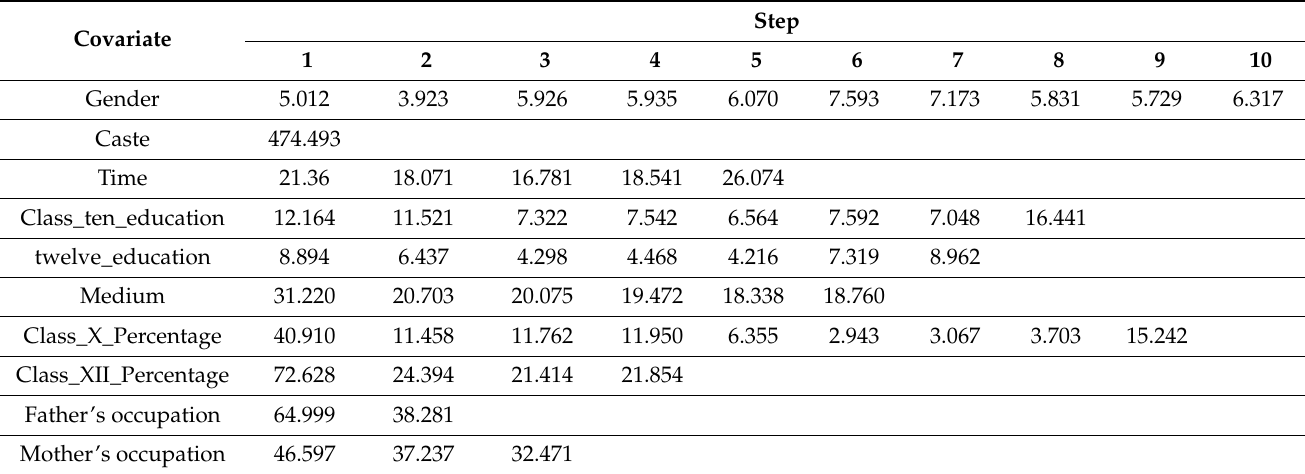
Table 3. Results of the likelihood ratio statistic for each